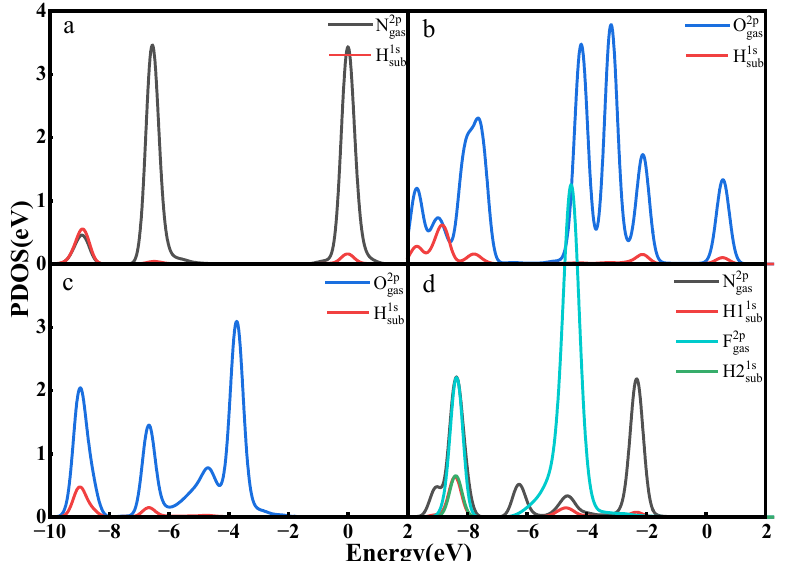
Figure 10. Partial electron density of states of Ti 3 C 2 (OH) 2 adsorbing ( a ) NO, ( b ) NO 2 , ( c ) N 2 O, ( d ) NF 3. In summary, the adsorption that occurs on the Ti 3 C 2 (OH) 2 surface is significantly dif- ferent from that of Ti 3 C 2 F 2 and Ti 3 C 2 O 2 , which has greater adsorption energy, more charge transfer, and stronger interactions. The reason is that the hydroxyl groups on the surface